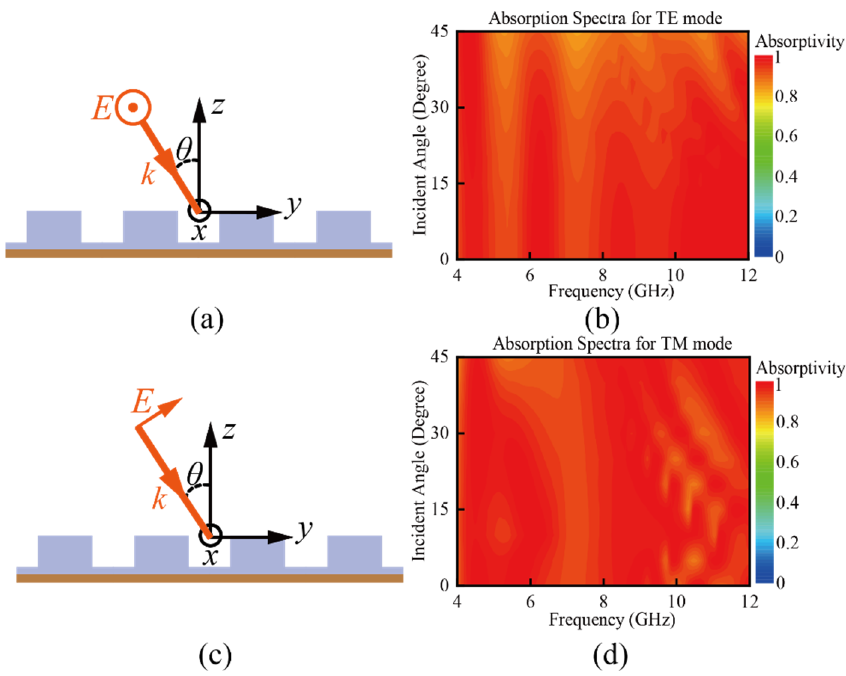
Figure 6. Schematic diagram of oblique-incidence waves for ( a ) the TE mode and ( c ) TM mode. Absorption spectra for oblique-incidence waves with different angles of incidence for ( b ) the TE mode and ( d ) TM mode.